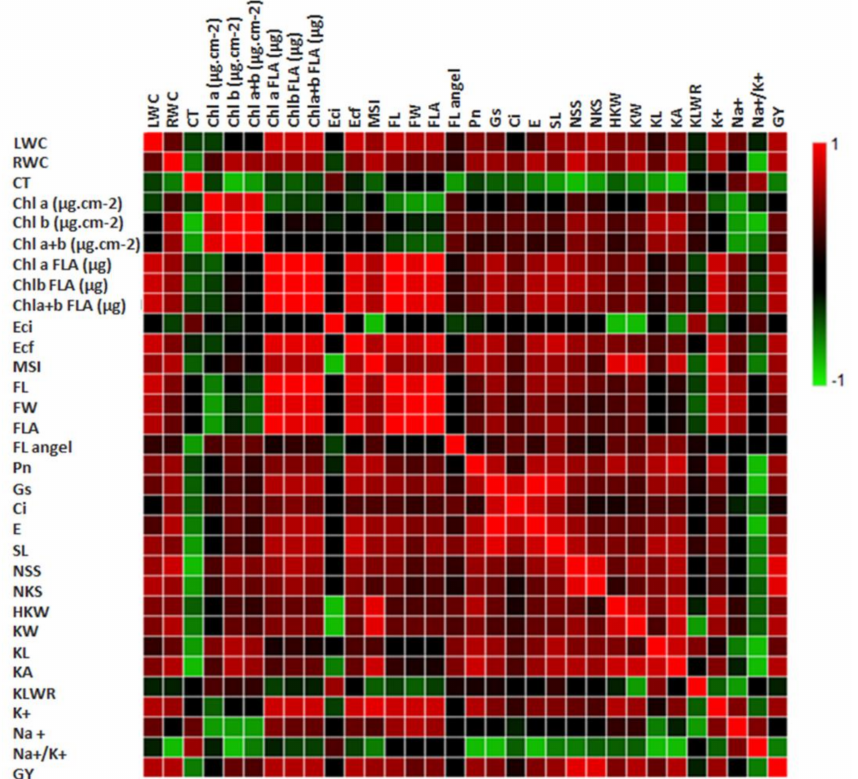
Figure 11. Correlation matrix among 32 measured traits of nine